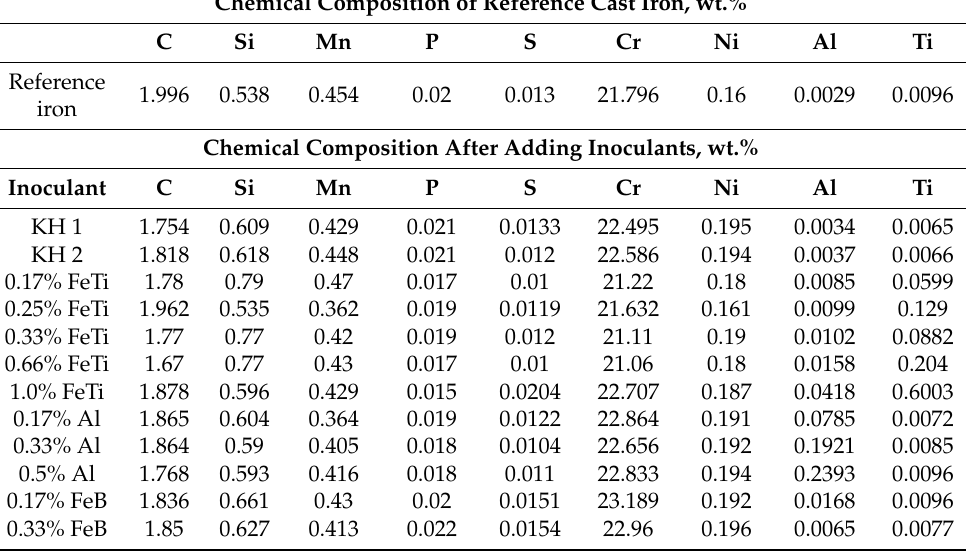
Table 1. Chemical composition of chromium cast iron and the inoculants used. Chemical Composition of Reference Cast Iron,